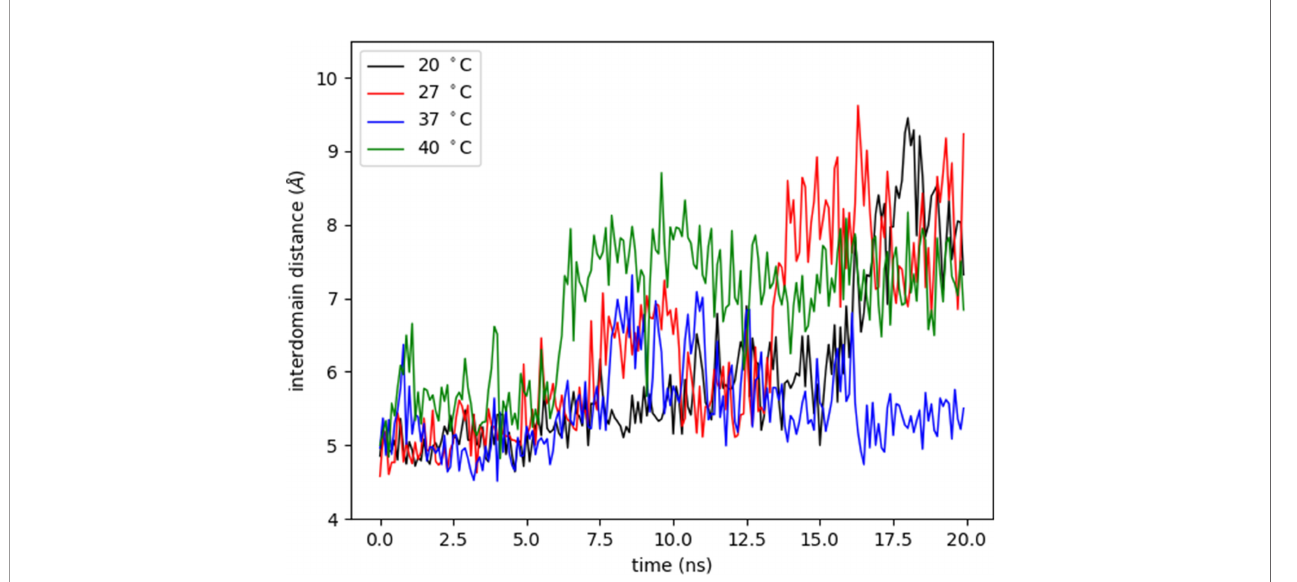
FIGURE 8 | Variation of interdomain distance with time at different temperatures. The interdomain distance was measured as the distance (Å) between CA atom of residue 251 from b -propeller domain and CA atom of residue 619 from catalytic domain at different temperatures (°C) during 20 nanoseconds